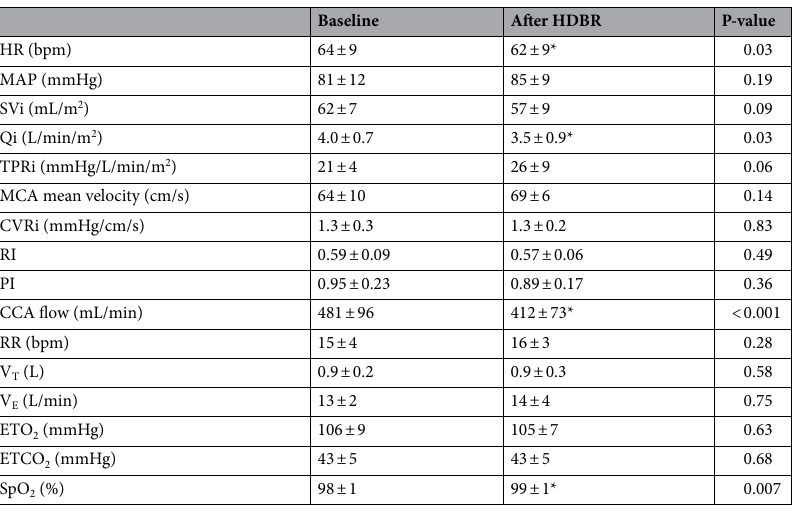
Table 1. Cardiorespiratory and cerebrovascular baseline comparisons before and after HDBR. HR heart rate, MAP mean arterial pressure, SVi stroke volume index, Qi cardiac index, TPRi total peripheral resistance, MCA middle cerebral artery, CVRi cerebrovascular resistance index, RI resistance index, PI pulsatility index, CCA common carotid artery, RR respiration rate, V E ventilation, V T tidal volume, ETO 2 end-tidal oxygen, ETCO 2 end-tidal carbon dioxide, SpO 2 arterial oxygen saturation. *Significant main effect of HDBR. All values are mean ±